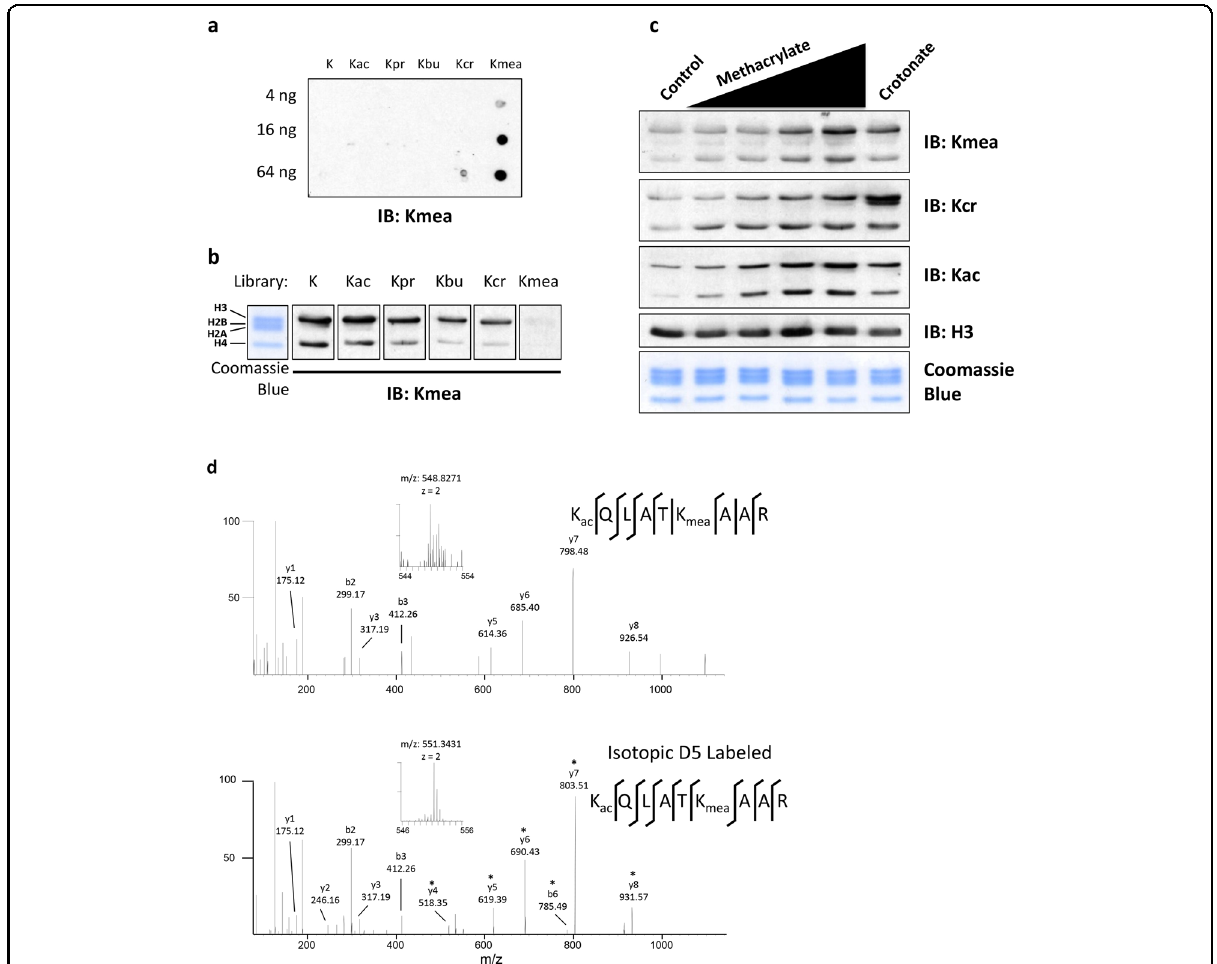
Fig. 3 Methacrylate is a metabolic precursor for Kmea. a Dot blot assay used to assess speci fi city of a pan anti-Kmea antibody. The Kmea peptide library consists of peptides with the sequence CXXXXXKmeaXXXXX where C is cysteine, X is a mixture of the 19 non-cysteine amino acids, and Kmea is methacryllysine. The control peptides libraries differ in modi fi cation status of the central lysine residue where the modi fi cations are abbreviated as follows: K, unmodi fi ed lysine; Kac, acetyllysine; Kpr, propionyllysine; Kbu, butyryllysine; and Kcr, crotonyllysine. The amount of peptides spotted in each row of the membrane is indicated. b Western blotting was performed using a pan anti-Kmea antibody on acid extracted HeLa histones. The pan anti- Kmea antibody was pre-incubated with peptide libraries for 4 h prior to immunoblotting of the western blot membrane. The sequences and abbreviations of the peptide libraries are the same as those indicated for the dot blot in a . c Western blot results for histones extracted from HeLa cells. HeLa cells were treated for 24 h with 1, 3, 5, or 10 mM sodium methacrylate or 10 mM sodium crotonate. d MS/MS spectra of H3K23mea peptide from HeLa histones following treatment with either methacrylate (top) or d-7 methacrylate (bottom). Asterisks (*) indicate b and y ions